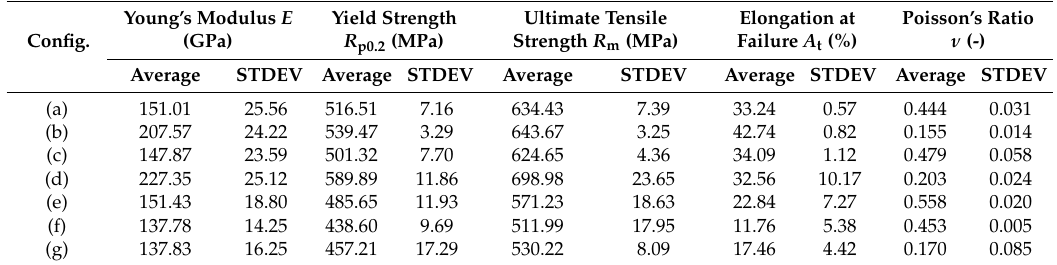
Table 6. Averaged results for the tensile properties of